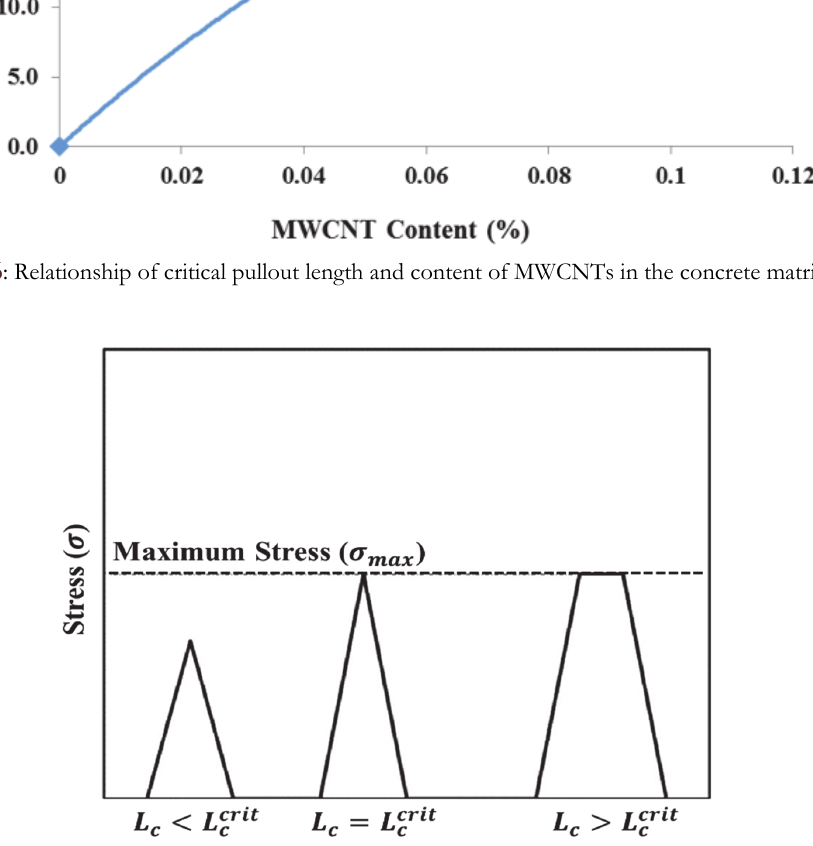
Figure 7 : Relationship of embedment length and stress development in MWCNTs